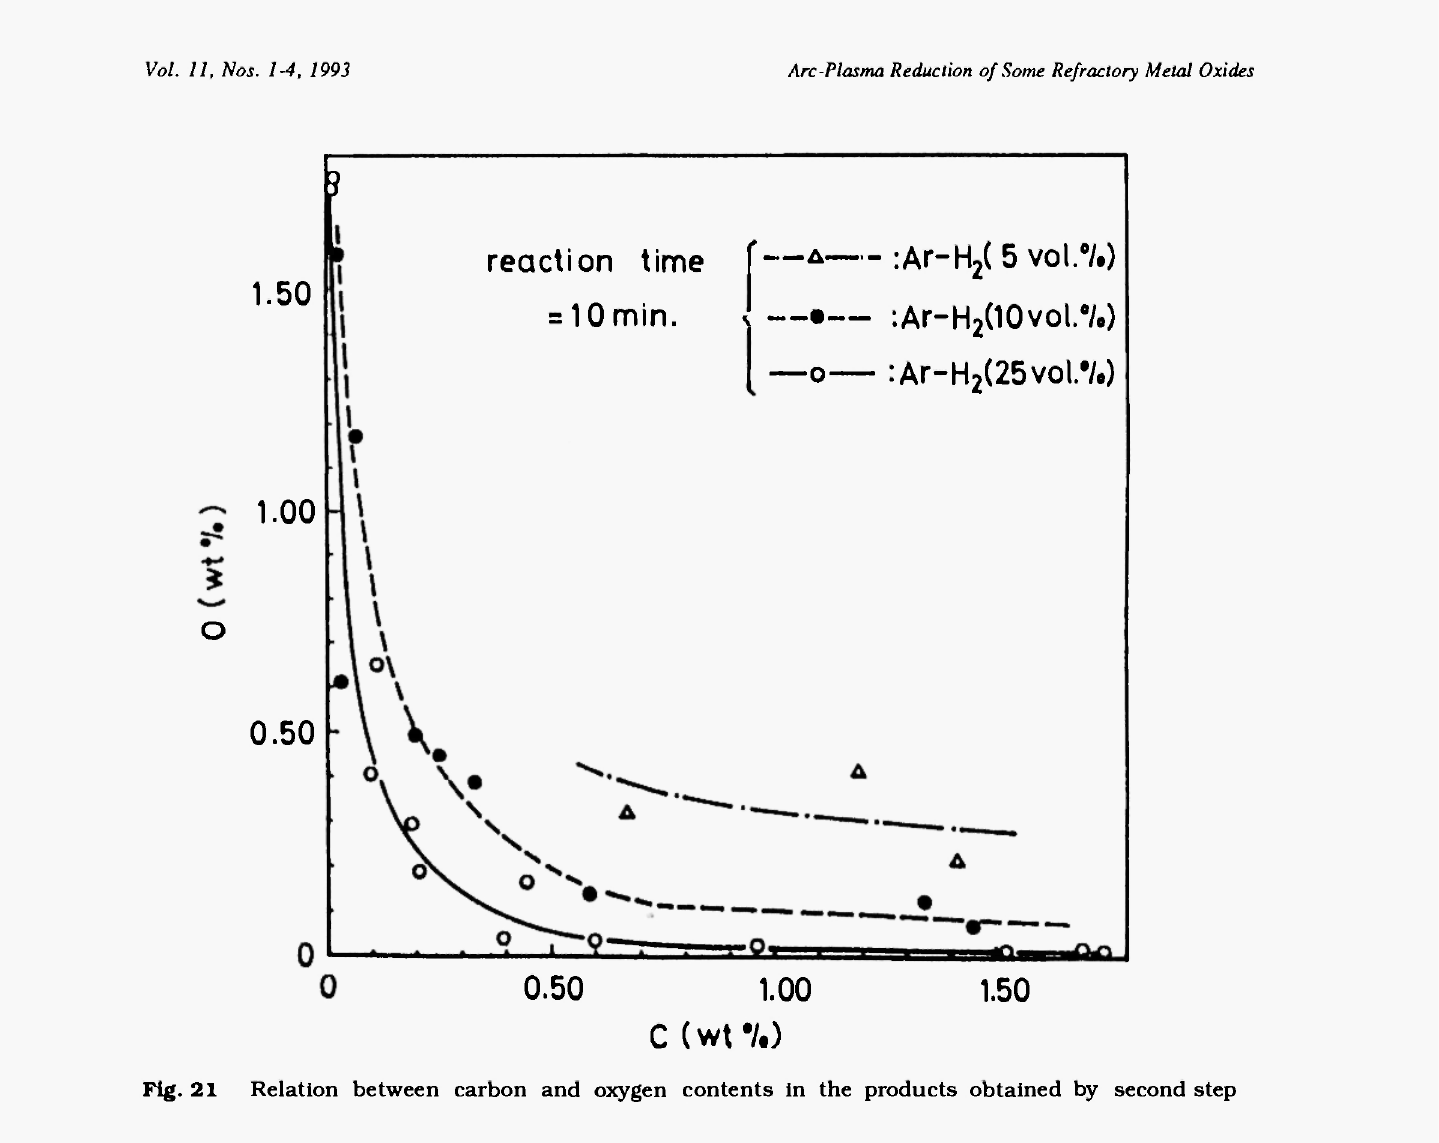
remarkably. The results of Rostker et al. /22/ and Seybolt et al. /23/ are shown by broken lines in Fig. 22. These agree well with our results. As for the vanadium metal in which the impurities were eliminated and refined through thermal decomposition or electro refining, a purity of over 99.9% and a value of less than 100 of H v are reported. Compared with these vanadium metals, the H v of our products is larger (H v = 180) due to small amounts of residual C and O. minimum H v is the same value of vanadium metal (>99.5% V) as reported by McKechnie et al. /7/. They used reduction with